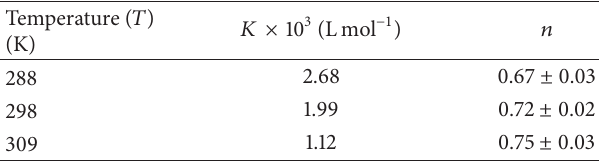
Table 2: Binding constant 𝐾 and the number of binding sites 𝑛